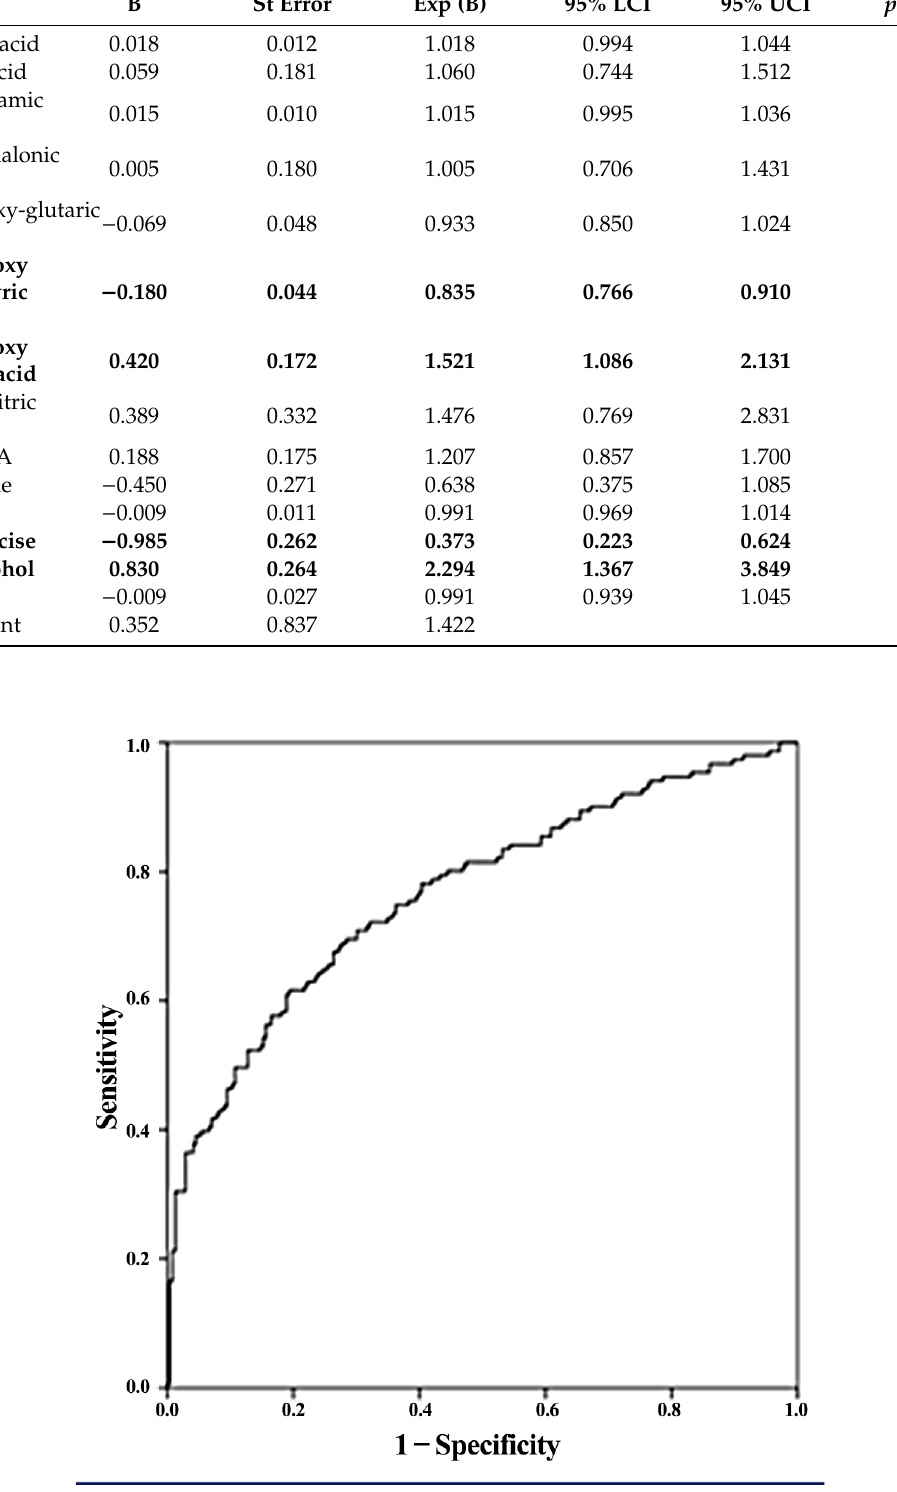
Figure 5. ROC Curve for the Logistic